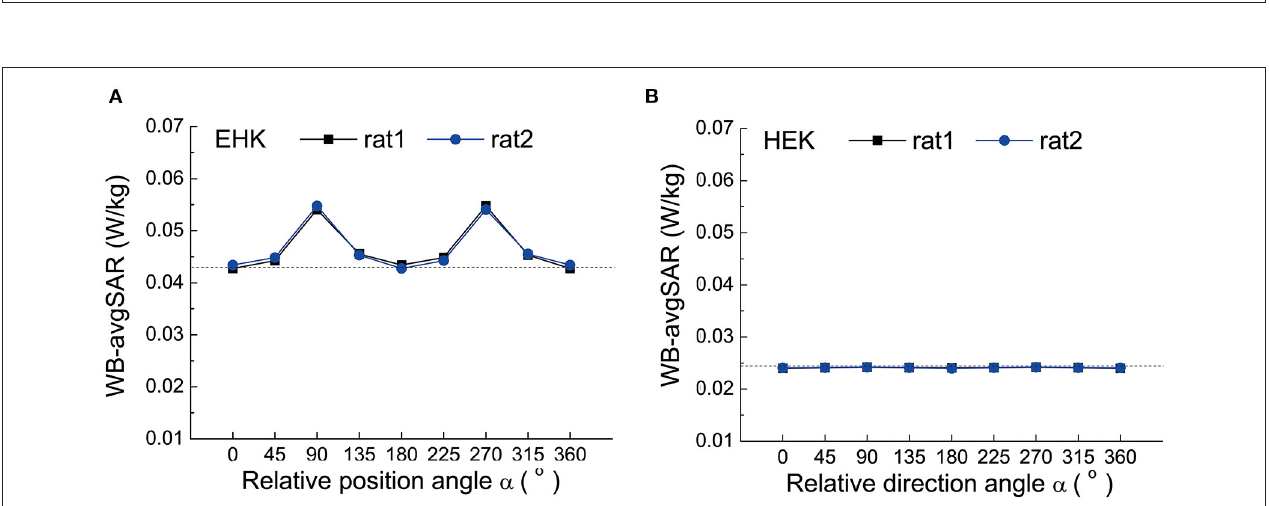
FIGURE 4 | The WB-avgSAR of two rats in different relative direction angles α (A) The simulation results under EHK; (B) The simulation results under HEK.